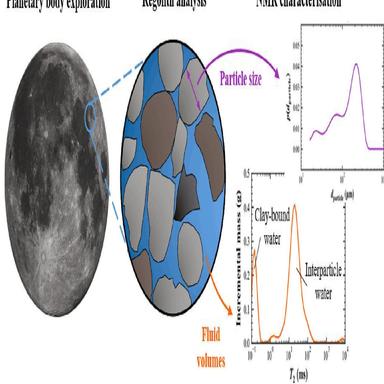
Conceptual image of NMR used for space exploration. Geophysical analysis of the regolith microstructure via NMR is able to characterise features such as an estimate of the particle size distribution as well as identifying fluid volumes (e.g. clay-bound and interparticle volumes).